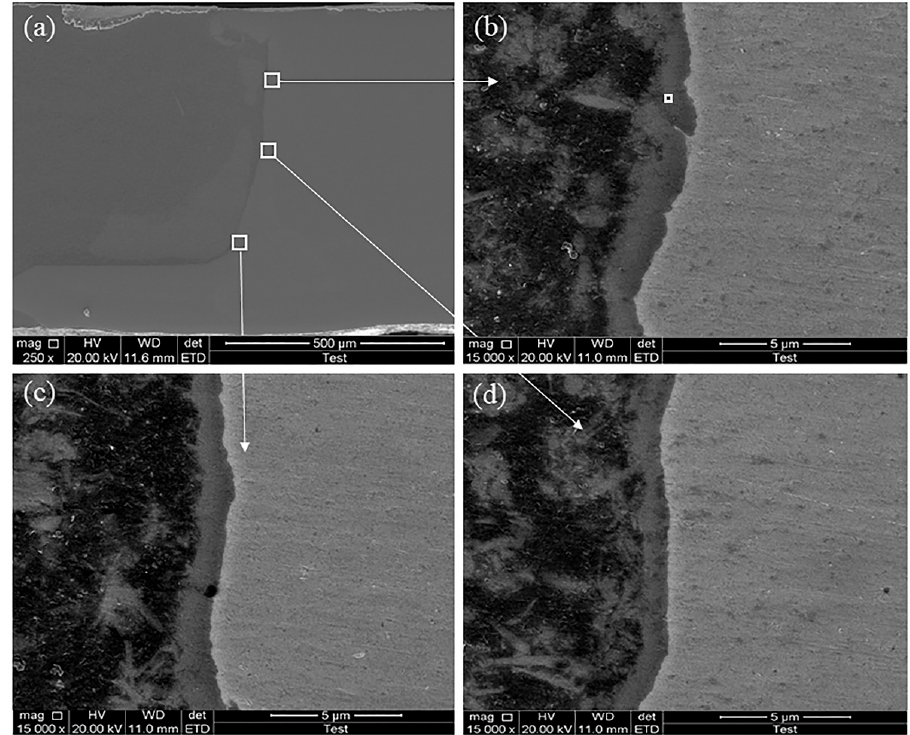
Figure 9. SEM image of ultra-HRS-FSW interface and EDS measuring position under a low tool offset. ( a ) Low magnification SEM picture, ( b ) SEM Al-Fe interface picture at the top and EDS point scan position, ( c ) SEM Al-Fe interface picture in the middle, ( d ) SEM Al-Fe interface picture at the bottom.